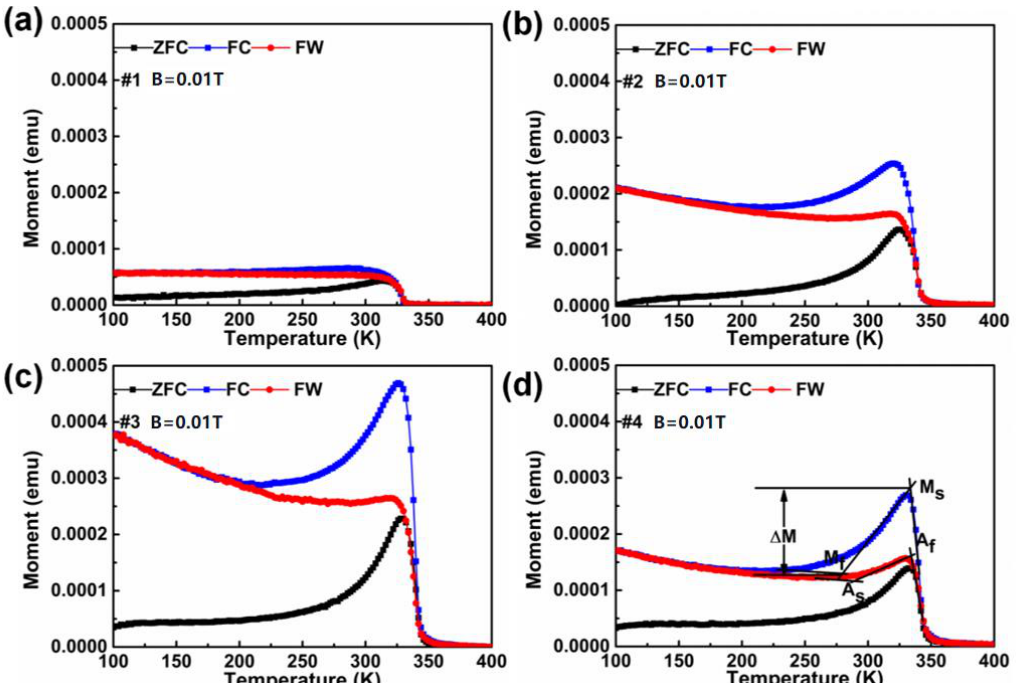
Figure 5. The M-T curves with ZFC, FC, and FW measurement for the Ni-Co-Mn-In alloy films. ( a ) #1, ( b ) #2, ( c ) #3, ( d )